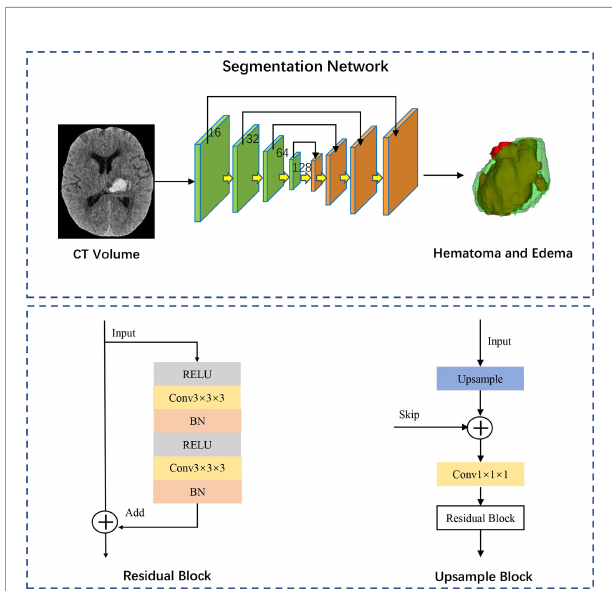
FIGURE 2 | Network architecture of segmentation model. The 3D-Unet structure comprises a down-sampling path and an up-sampling path and each path in the network comprised the same four modules. The green down-sampling path comprises the Residual Block and a 1x1 convolution with versus 2. The feature maps with channels of 16, 32, 64 and 128 are gradually generated through the down-sampling path. The orange up- sampling path is comprised of the skip connections and Upsample Block. Each same scale of feature maps is skip connected during the up-sampling procedure. Feature maps with strengthened semantic information are generated with Element-wise. The segmentation network fi nally outputs the features with three channels activated by the Softmax layer and transformed into a probability map of background, hematoma, and edema. RELU, recti fi ed linear unit; BN, batch